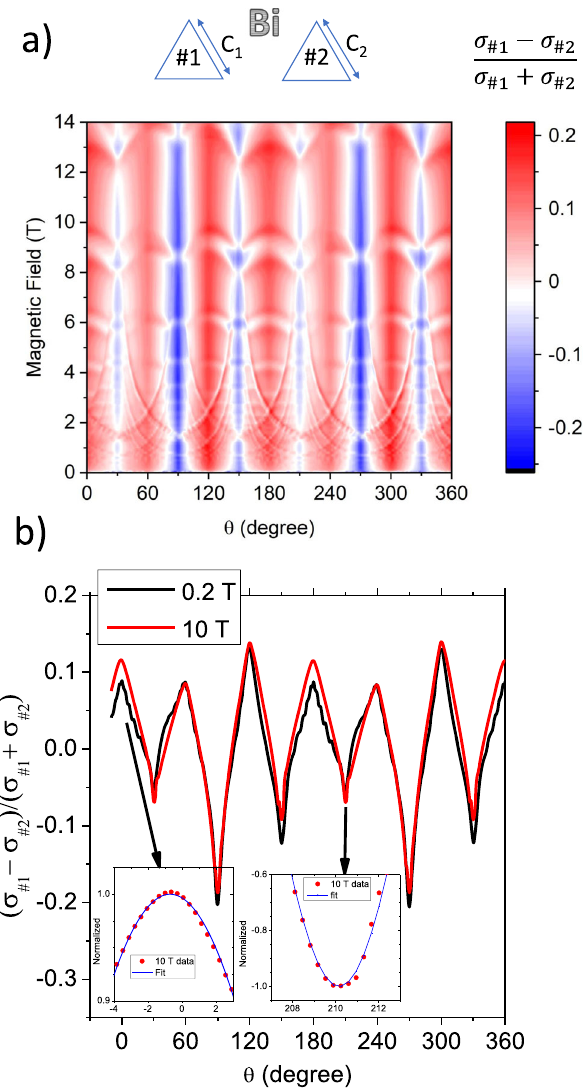
Fig. 5 Field and angle dependence of the excess boundary conductance.